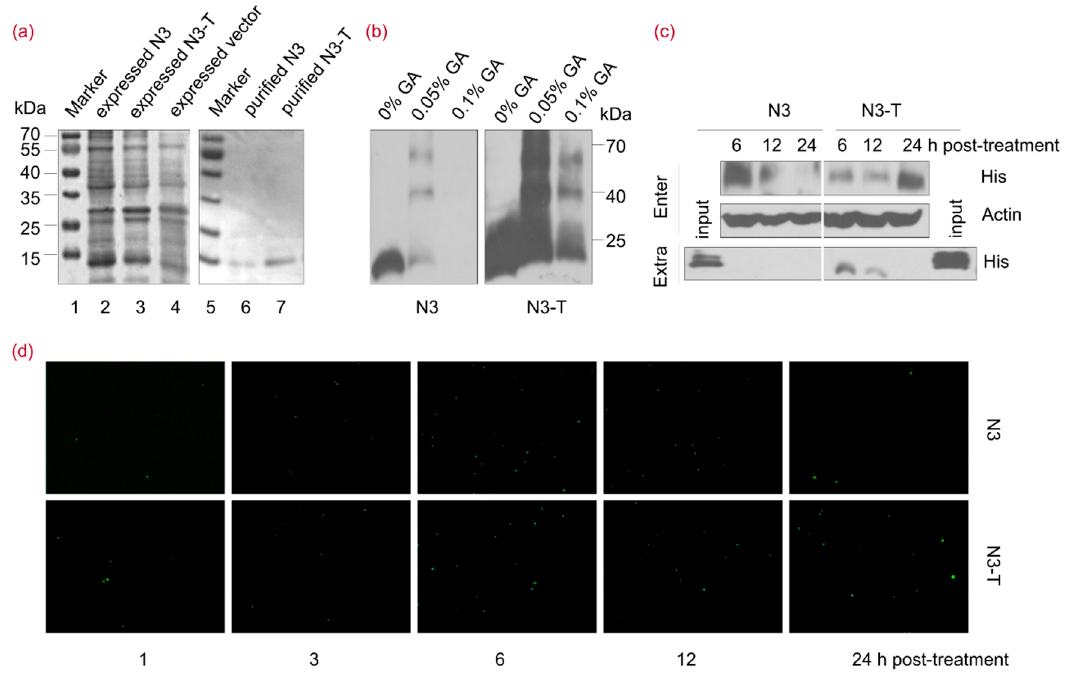
Figure 4. NOP53-derived Protein N3-T Can Penetrate into Cells. ( a ) Lanes 1–7, His-fusion N3 and N3-T proteins were purified using a His-Ni column and the fusion proteins were analyzed by 12% SDS-PAGE. Lane 1, expressed vector control protein; lane 2, expressed His-fusion N3; lane 3, expressed His-fusion N3-T; lanes 4 and 5, protein molecular-weight markers in kDa as indicated; lane 6, purified His-fusion N3; lane 7, purified His-fusion N3-T; ( b ) Purified His-fusion N3 and N3-T proteins were treated with 0%, 0.05%, 0.1% GA for 15 min at 4 °C, followed by SDS-PAGE and immunoblotting with an antibody against His; ( c ) HeLa cells in T-25 flasks were treated with N3 (20 µg/mL) or N3-T (20 µg/mL) for the indicated times. The cells and culture supernatant were harvested for detection using an anti-His antibody; ( d ) HeLa cells in 24-well plate were treated with N3 (20 µg/mL) or N3-T (20 µg/mL) for the indicated times. The cells were fixed and reacted with antibodies against His. Nuclei were stained with DAPI. Images were captured using 10 × objectives with an Olympus IX73 microscope.